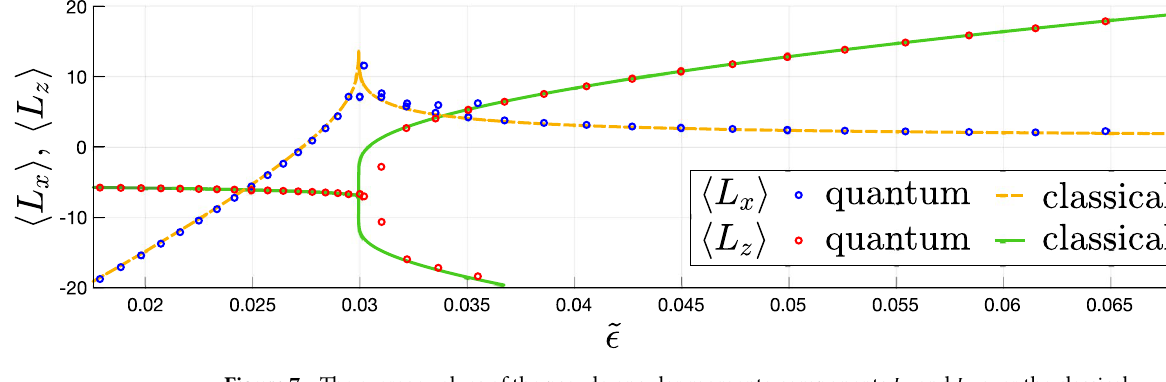
Figure 7. The average values of the pseudo angular momenta components L x and L z over the classical trajectories with the dimensionless energy of the quantum Hamiltonian with the eigenenergies the following values of the Hamiltonian parameters: N 1.816 g /α 1 ≈